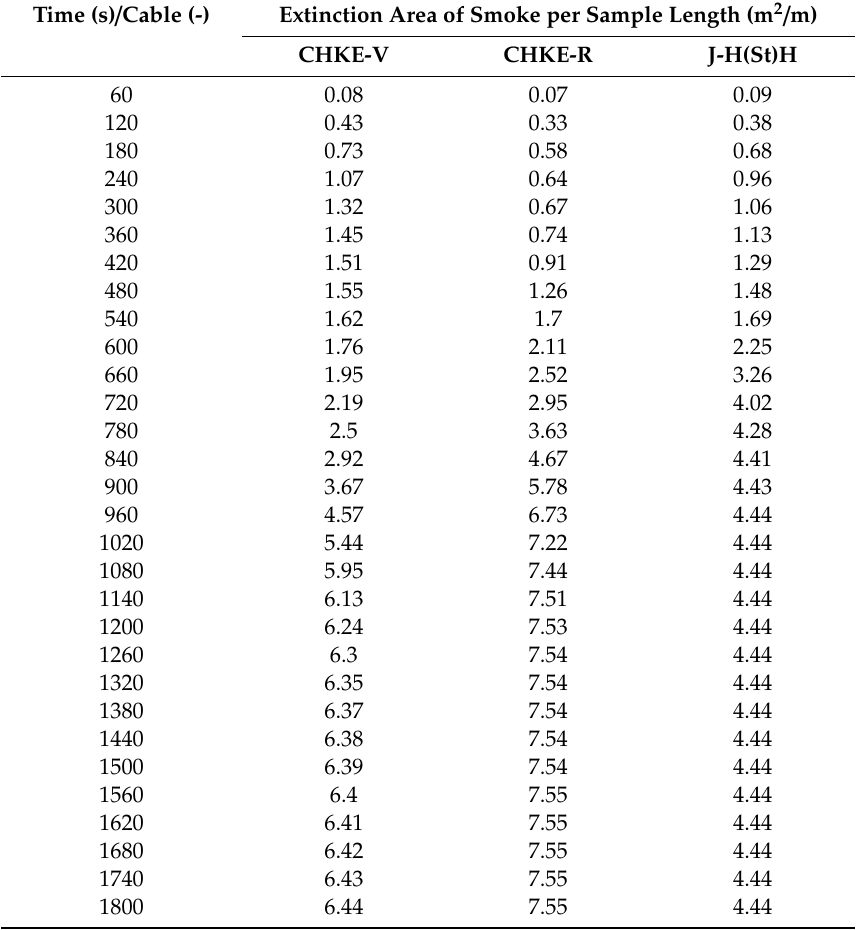
Table 3. Extinction area of smoke per meter of cable